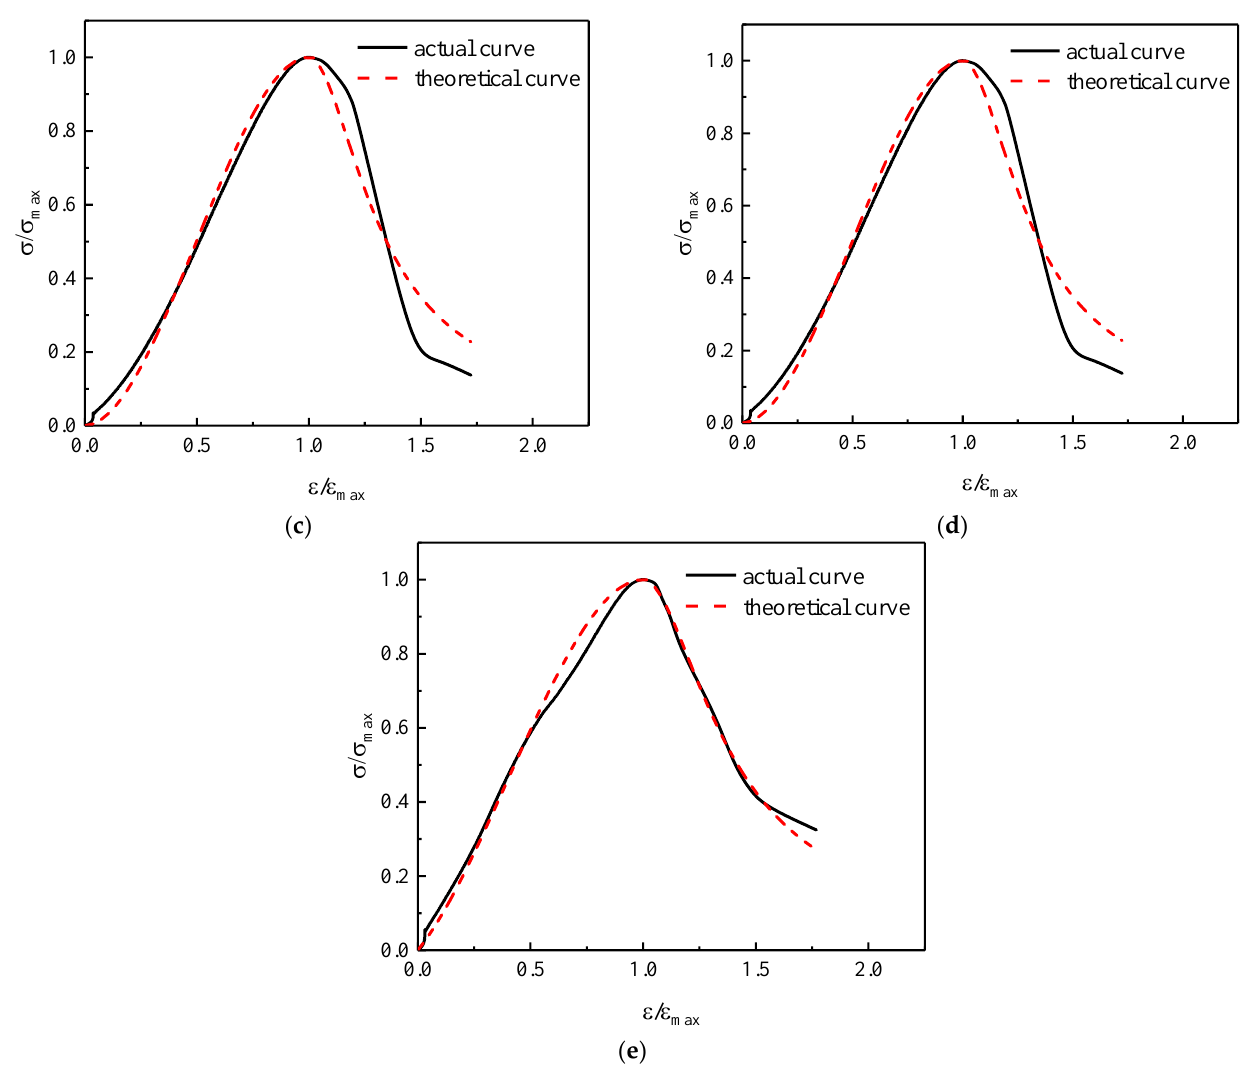
Figure 8. The comparison between fitting curves and test curves. ( a ) TRAC. ( b ) TRAC-PP0.3. ( c ) TRAC-PP0.6. ( d ) TRAC-PP0.9. ( e ) TRAC-PP1.2.